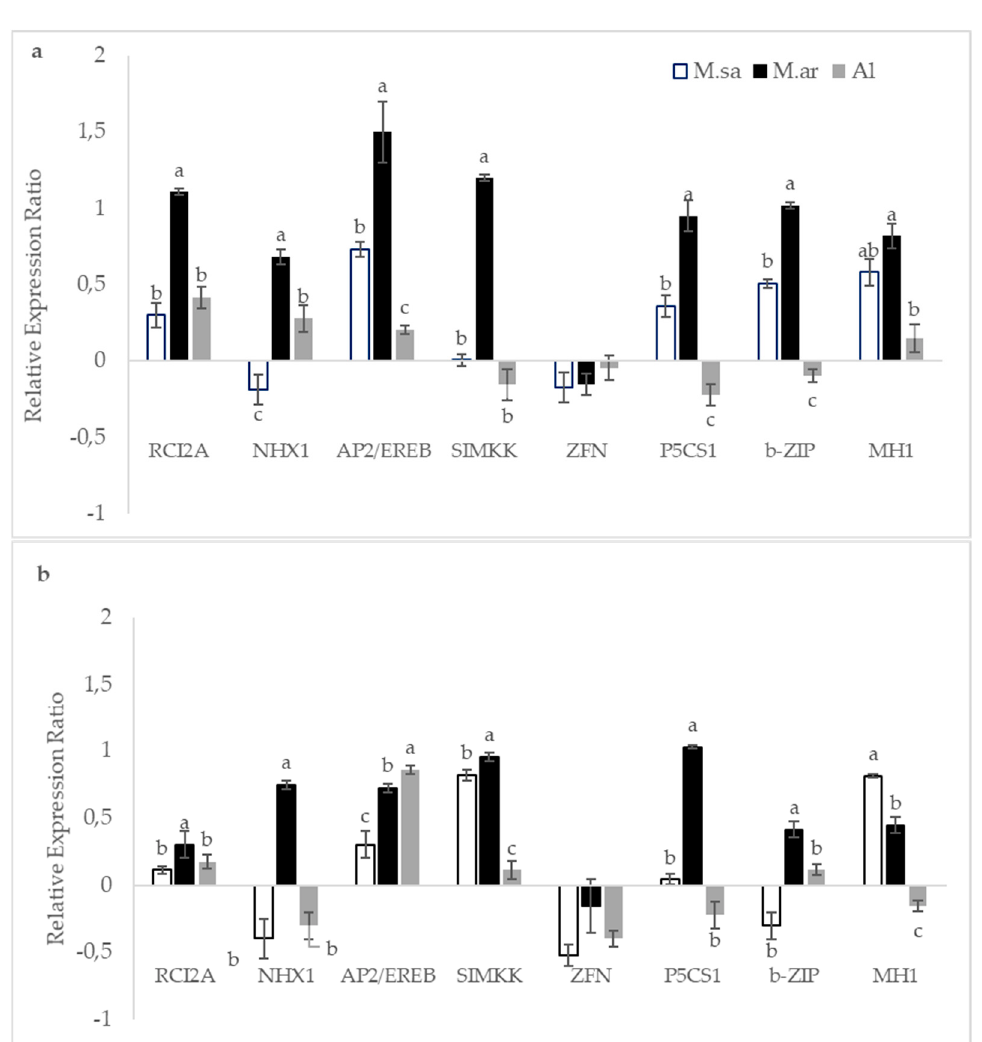
Figure 3. RCI2A , NHX1 , AP2/EREB , SIMKK , ZFN , P5CS1 , bzip , and MH1 relative expression level for M. arborea (M.ar), M. sativa (M.sa) and Alborea (Al) under drought stress for leaves (a) and roots (b). Error bars indicate the mean ± SE. The different small letters refer to the significant differences between the entries in the same treatment at p <0.05 (Tukey test). Relative expression ratios were calculated according to the 2 −∆∆ Ct method. More speci fi cally to calculate ∆∆ Ct value, the control sample of each entry ( M. arborea , M. sativa and Alborea) was used. MS-Actin-2 was the endogenous gene used for normalization.